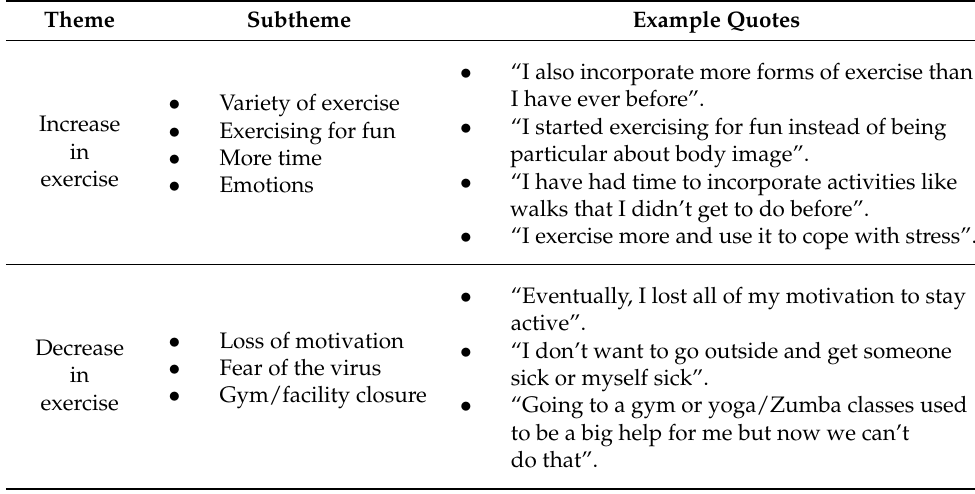
Table 6. Themes and subthemes in open-ended